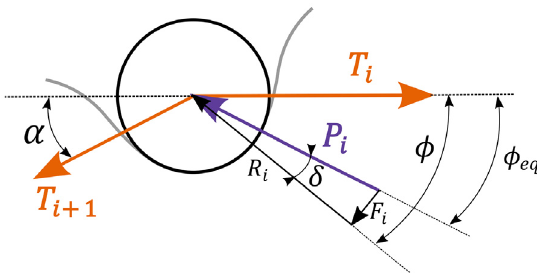
Fig. 11. Introduction of the friction angle d .